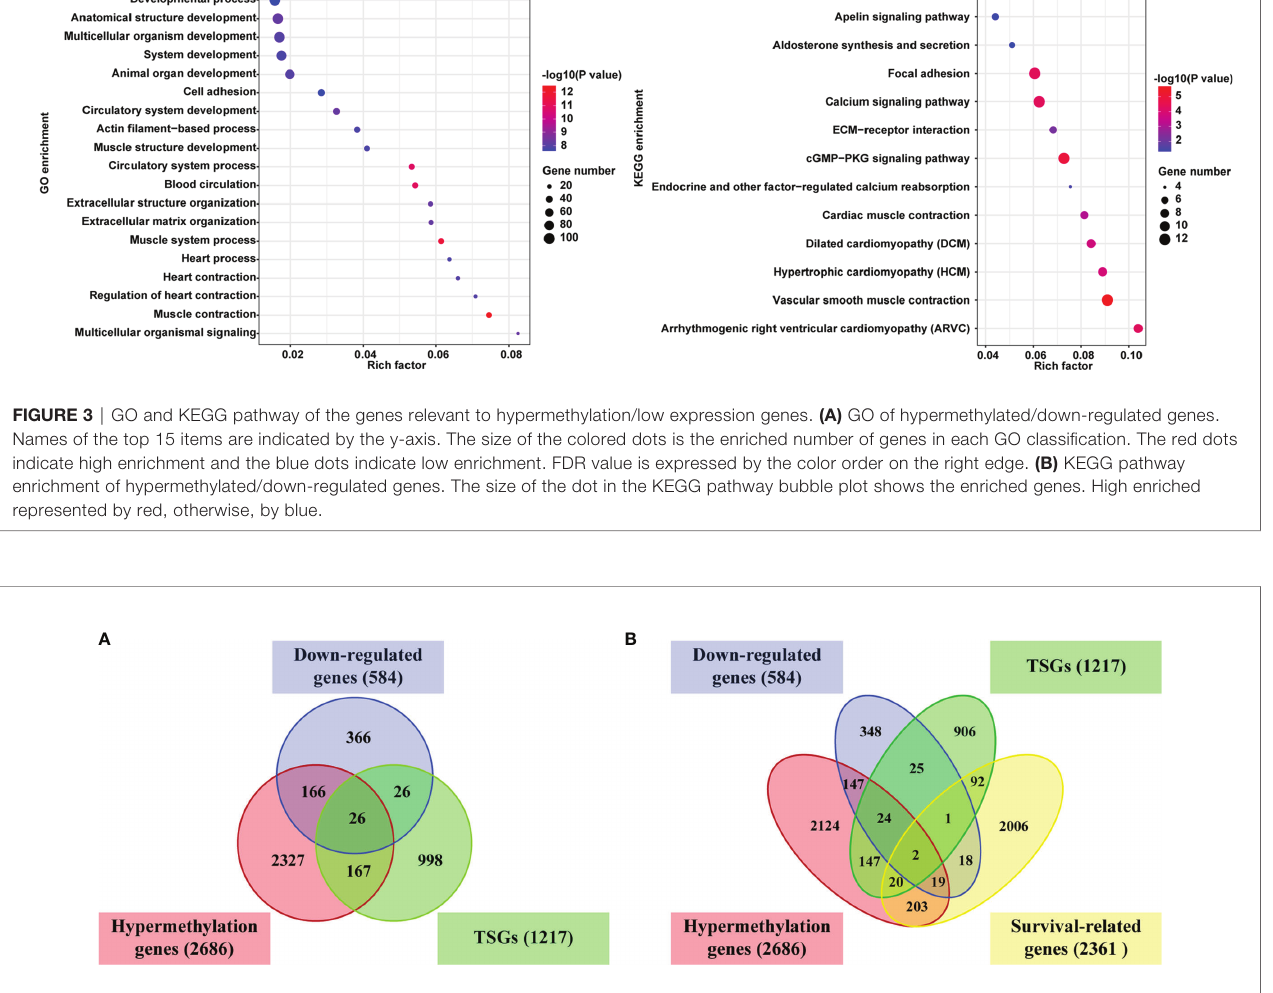
FIGURE 4 | Venn diagram of overlapping genes. (A) Venn diagram of overlapping genes in down-regulated genes (blue circle), and hypermethylation genes (red circle), and TSGs (green circle). (B) Venn diagram of overlapping genes in down-regulated genes (blue circle), and hypermethylation genes (red circle), TSGs (green circle), and survival-related genes (yellow circle). TSGs, tumor suppressor